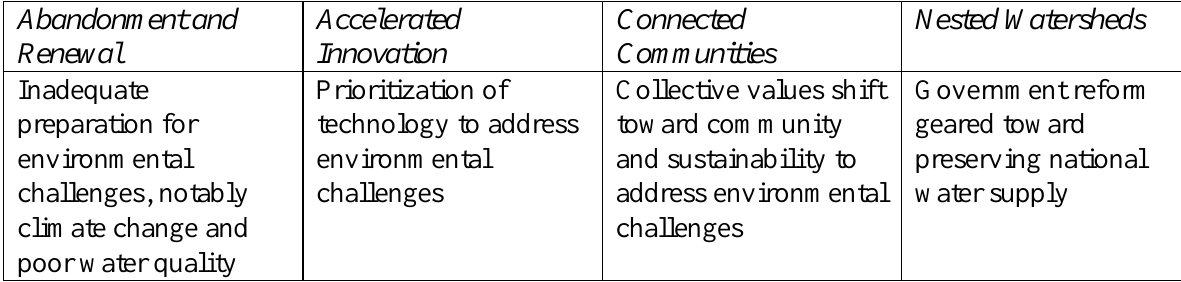
Table A1.1. Overarching Change Agent by Scenario Abandonment